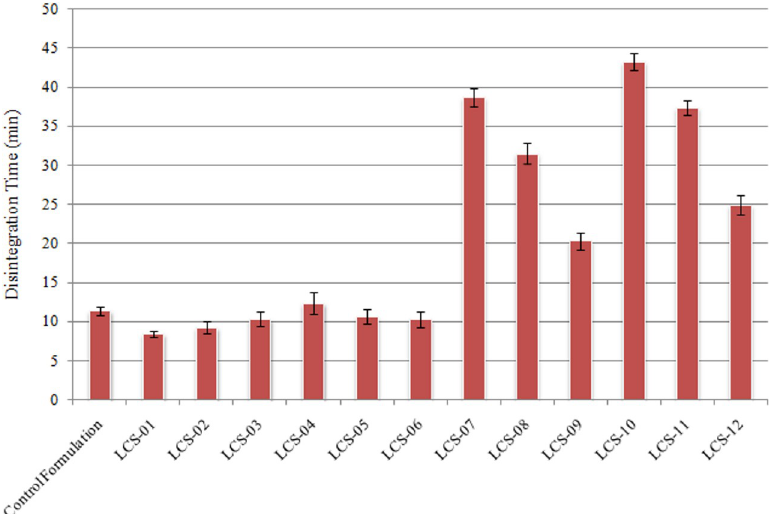
In vitro release of clopidogrel from liquisolid compacts Dissolution rate from liquisolid compact was determined in accordance with the official com-